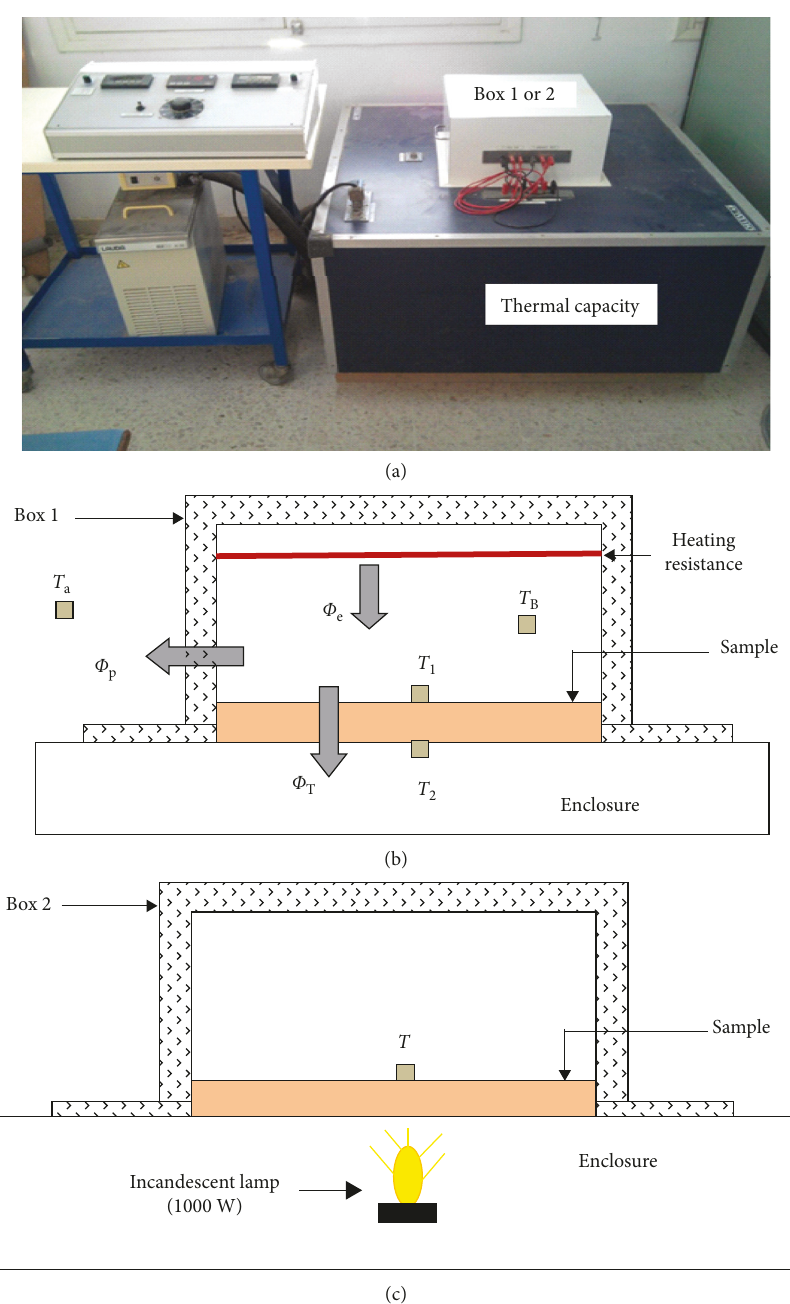
Figure 7: The boxes method test. (a) The boxes method apparatus. (b) Thermal conductivity measurement. (c) Thermal diffusivity